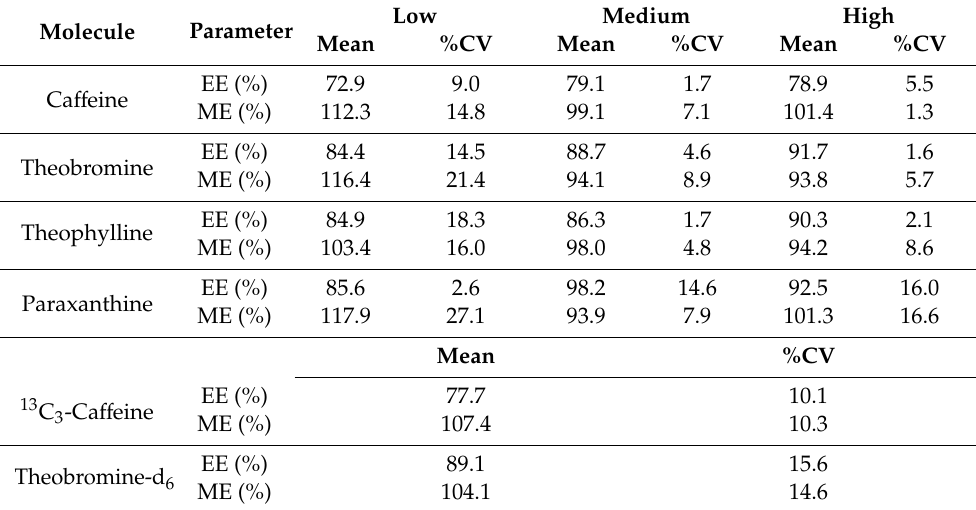
Table 3. Extraction e ffi ciency (EE) and matrix e ff ect (ME) results for ca ff eine, theobromine, theophylline, paraxanthine and the internal standards 13 C 3 -ca ff eine and theobromine-d 6 . The evaluation was performed for three di ff erent concentration levels, the same used as quality control